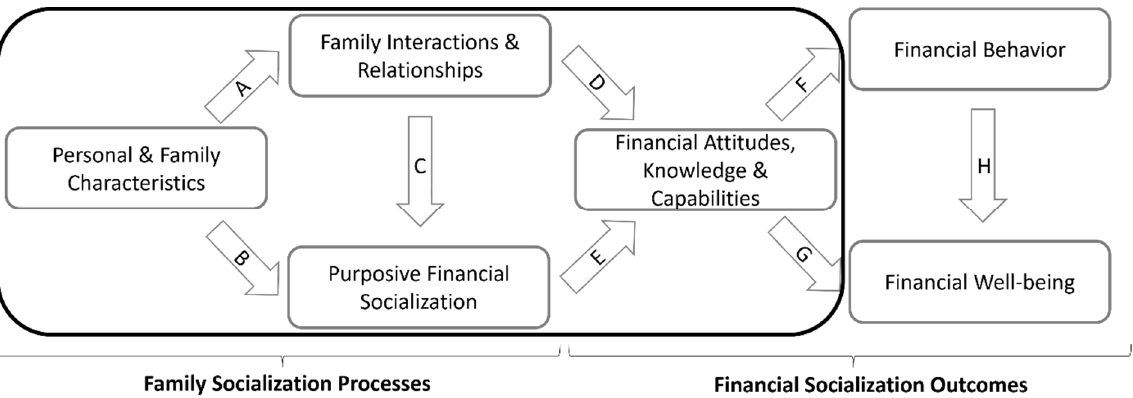
Figure 1. Model of the Processes and Outcomes of Family Financial Socialization. Note. Illustration based on Gudmunson and Danes (2011, p.